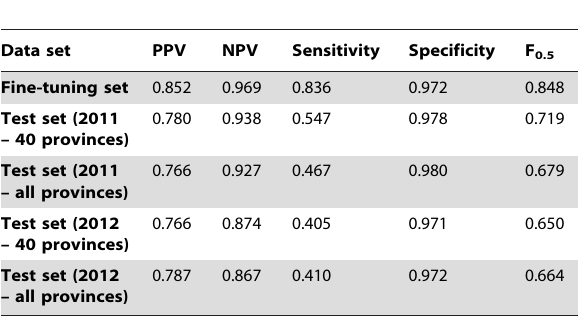
Table 4. FARM prediction results for Philippines optimized